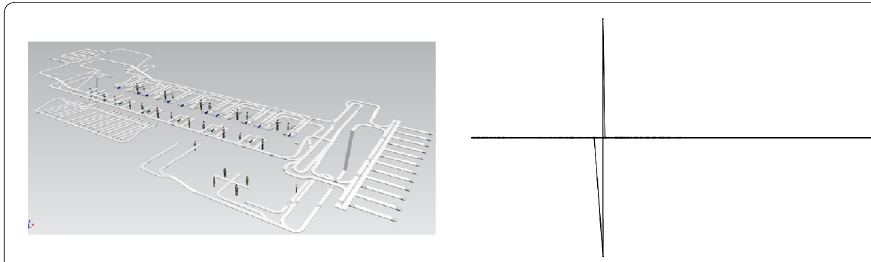
Figure 14 Graph of the buffer